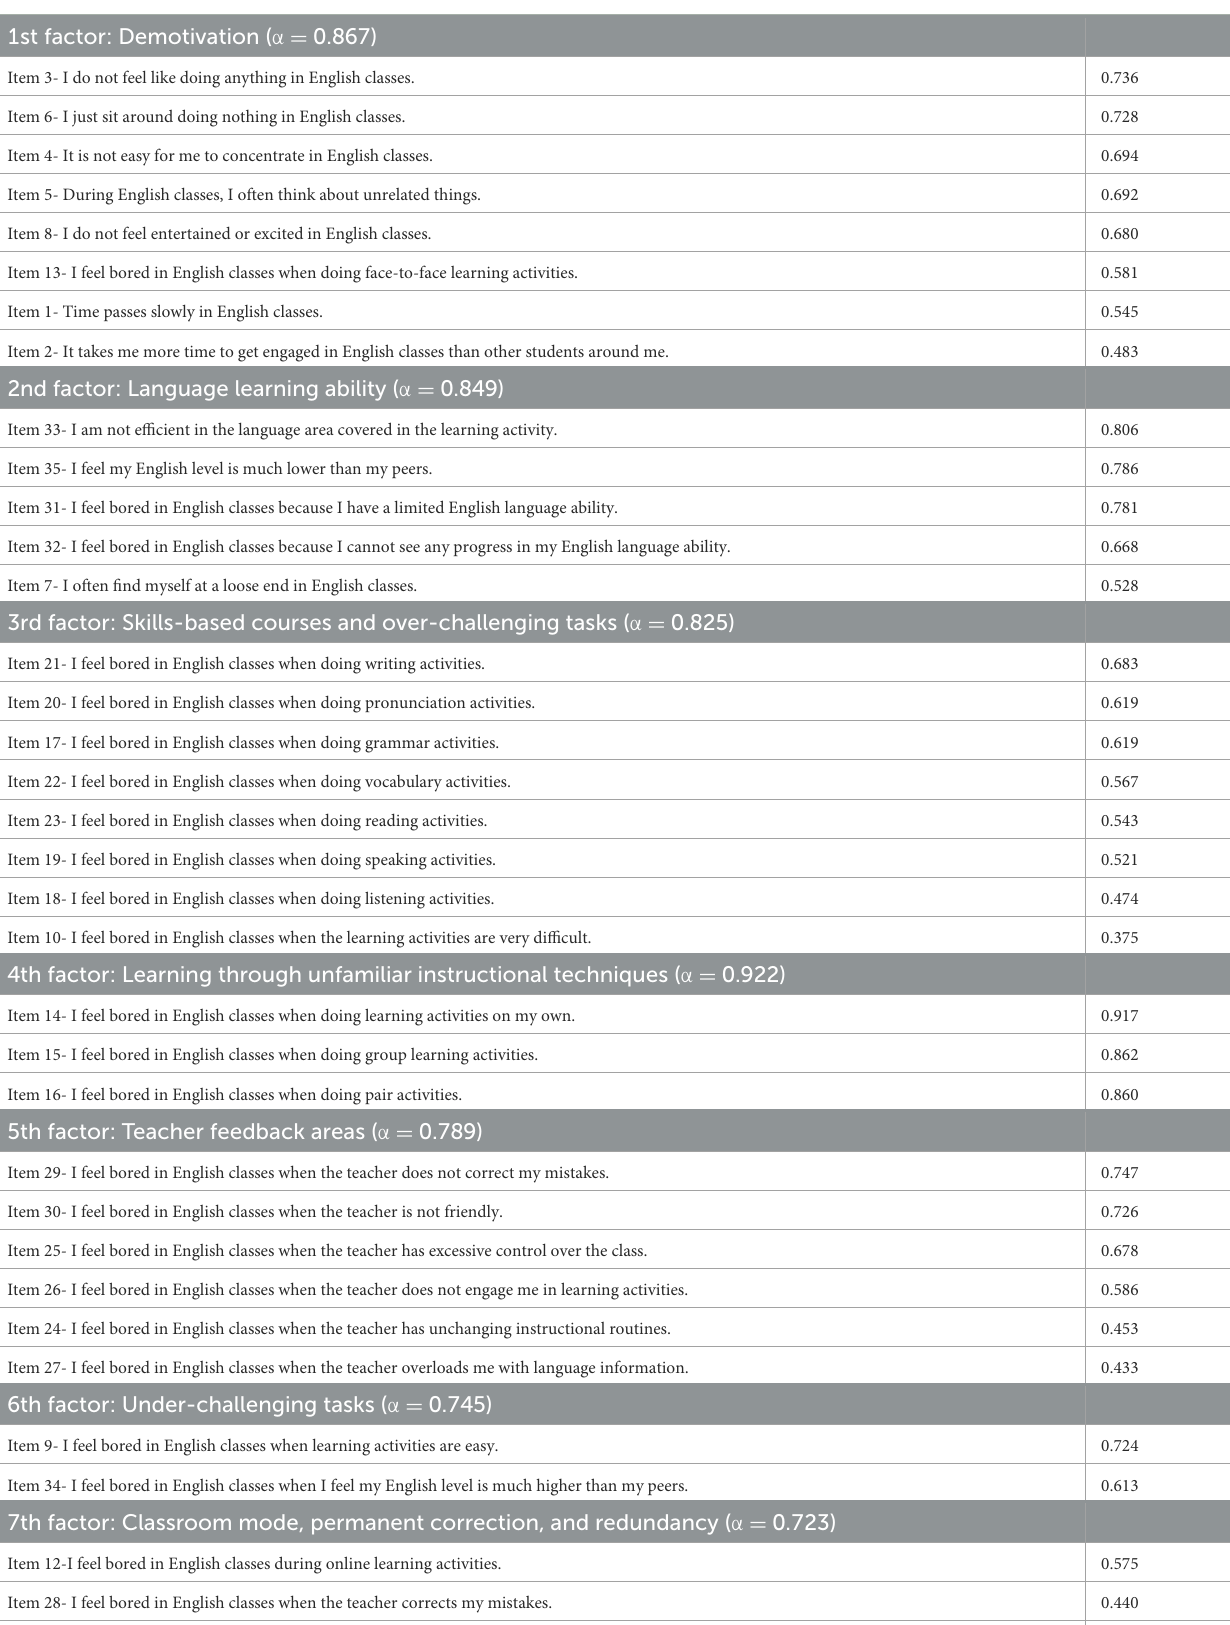
TABLE 1 Results of the exploratory factor analysis and the loadings of the questionnaire